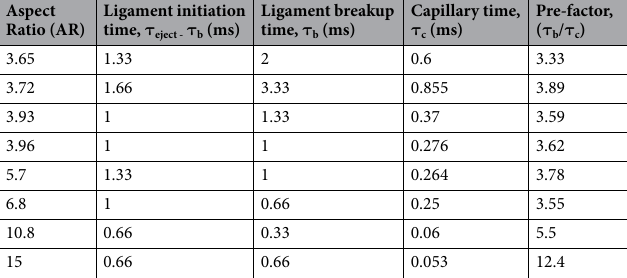
Shape oscillations. Figure 7a shows a typical minor bubble breakup event, which induces small scale surface oscillations on the parent droplet. The droplet recuperates from the mild oscillations within a short time (~50 ms). The centroid trajectory of the parent droplet following the onset of minor bubble breakup is shown in Fig. 7b. Upon breakup, the droplet centroid follows an orderly trajectory and relocates itself at a distance of 0.025 mm. The maximum spatial displacement in the droplet centroid co-ordinates due to minor breakup events is within ~6% of the initial droplet diameter. On the contrary, the droplet centroid oscillation resulting from the onset of major bubble expulsion event takes a relatively longer time (~100–200 ms) to decay compared to that of minor bubble breakup. Besides, the maximum spatial displacement in the droplet centroid co-ordinates due to major breakup events is within ~18% of the initial droplet diameter. This high-intensity major bubble breakup causes violent volumetric shape distortions and leads to large scale oscillations as the droplet experiences recoil thrust due to the breakup of a relatively large sized bubble. Upon breakup, the ligament is pushed out of the parent droplet because of the recoiling motion of the liquid surface along with the discharge of ethanol/butanol vapor. Because of the strong recoiling motion, the probability of ligament ejection is also high for major breakup events. The breakup results in repetitious axis-switching and